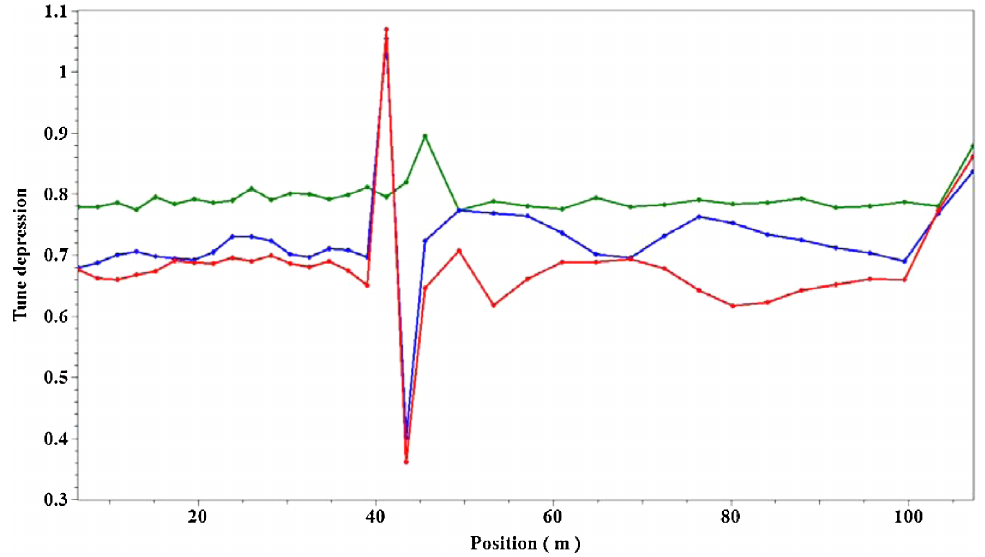
FIG. 2. Tune depression along the spoke sections in the main linac ( X in red, Y in blue, and Z in